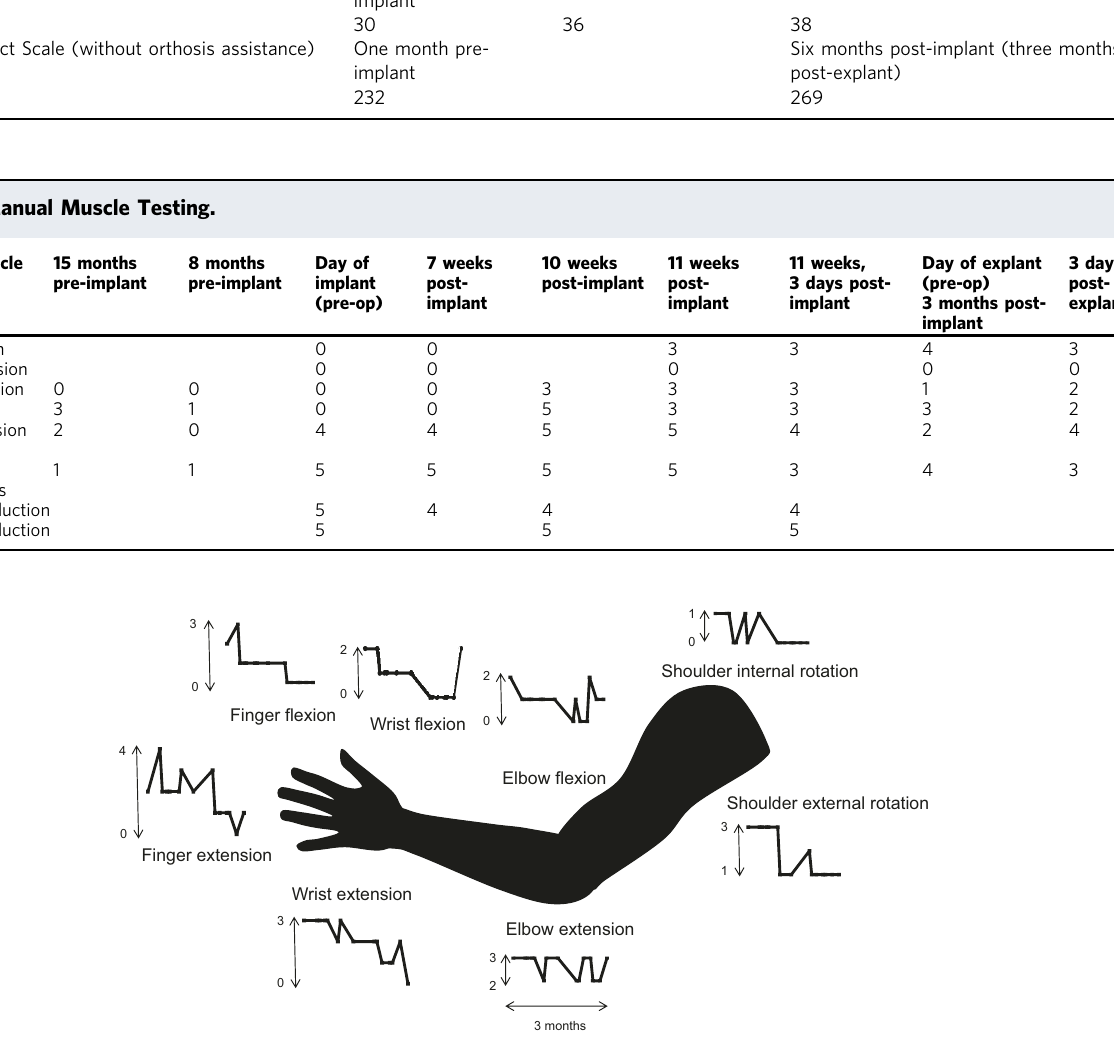
Fig. 7 Modi fi ed Ashworth Scale variation across time. The Modi fi ed Ashworth Scale ranges from 0 (normal) to 4, most spastic. These measurements were recorded serially over the three-month implantation phase and are shown graphically. Qualitatively, spasticity appeared to gradually decrease during this duration. Numerical data that was used to generate this fi gure is available in Supplementary Data